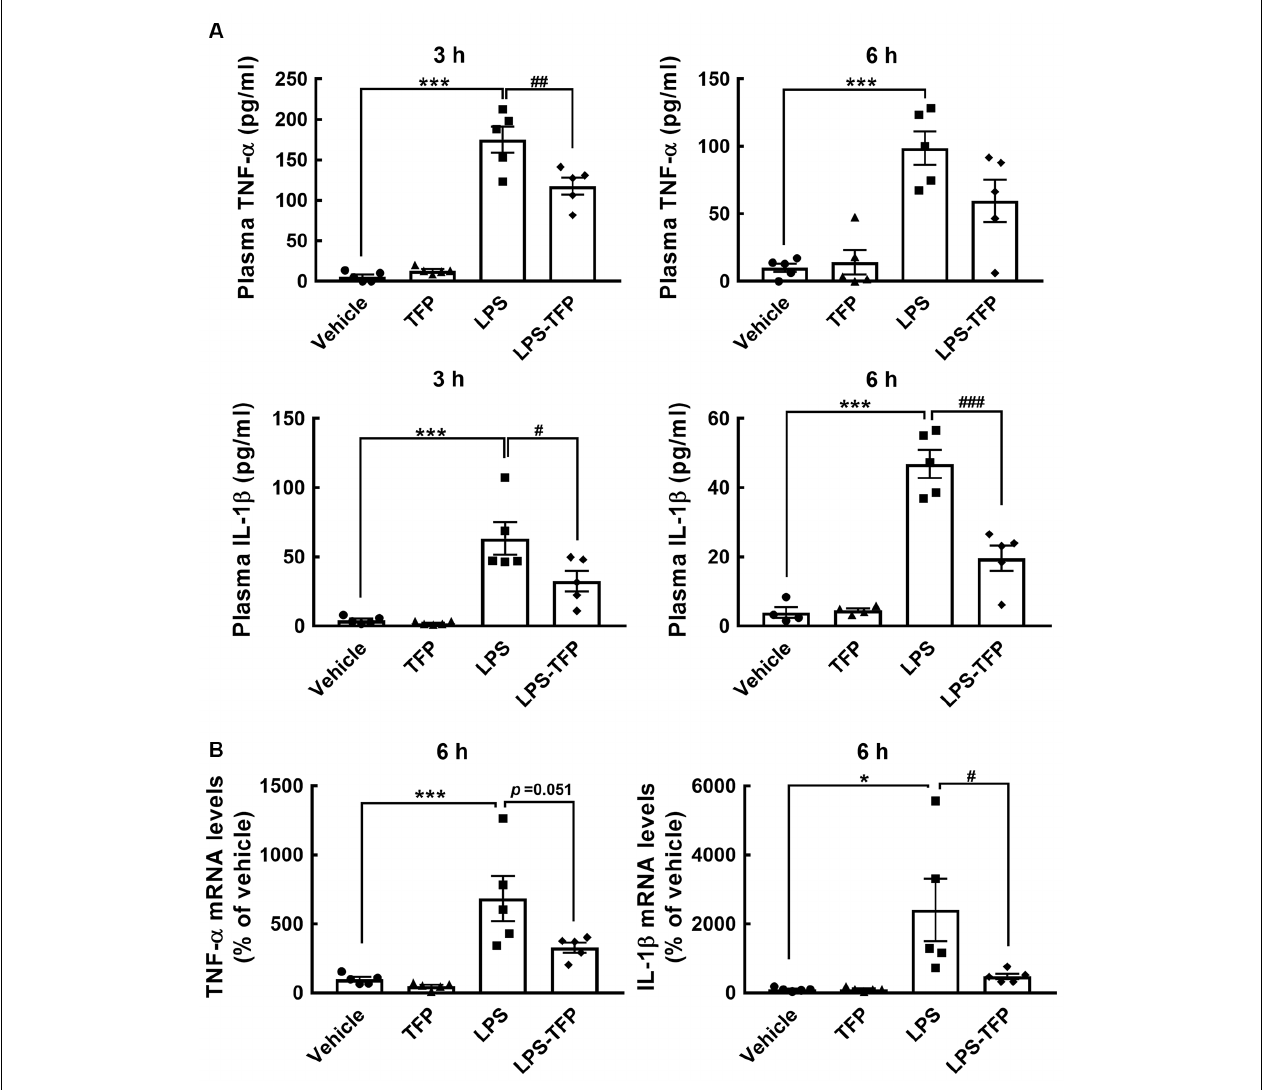
FIGURE 2 | TFP inhibits LPS-induced production of TNF- α and IL-1 β in the plasma and hypothalamus. Animals were divided into four groups that received a bolus peripheral injection of vehicle, TFP (2 mg/kg), LPS (1 mg/kg), or LPS plus TFP. Blood samples from the four animal groups were collected at 3 and 6 h post injection for TNF- α and IL-1 β ELISAs (A) , and then hypothalamic RNA isolation was conducted for the determination of TNF- α and IL-1 β mRNA expression (B) after animals were sacrificed at 6 h post injection. The data are presented as the mean ± SEM ( n = 5 animals in each group). Samples from five animals per group were used for most assays, whereas samples from four animals were used for the IL-1 β ELISA at 6 h (A) . Data are presented as the mean ± SEM ( n = 5 animals for each group). Each dot represents one animal. * p < 0.05, *** p < 0.001 vs. Vehicle; # p < 0.05, ## p < 0.01, ### p < 0.001, vs.